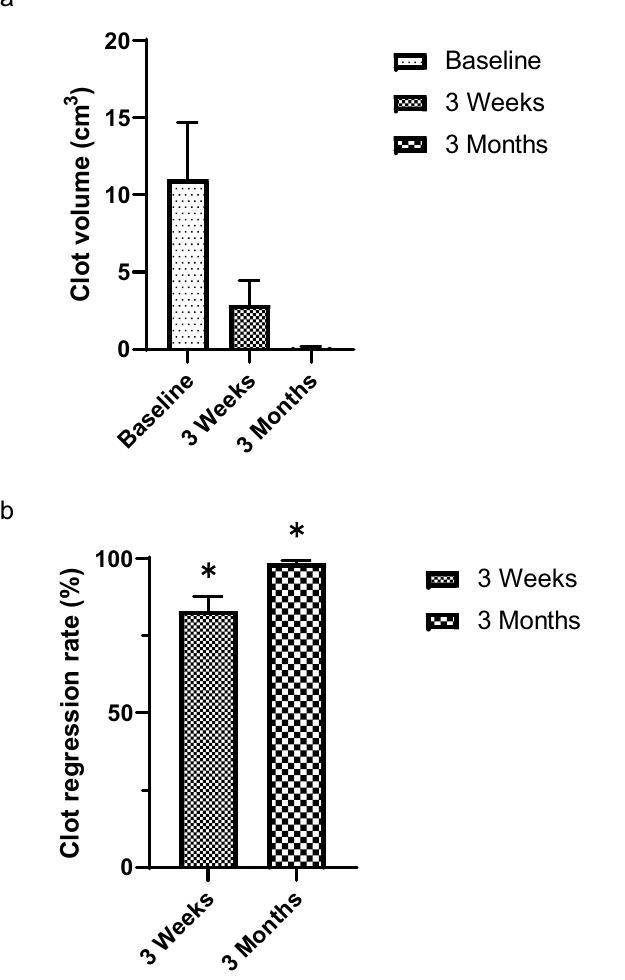
Figure 3. Clot-regression effect of rivaroxaban. ( a ) Clot volume assessed by contrast-enhanced CT at baseline, 3 weeks, and 3 months after rivaroxaban initiation. ( b ) Clot-regression rates 3 weeks and 3 months after rivaroxaban initiation. Data are expressed as mean ± standard error. * p <